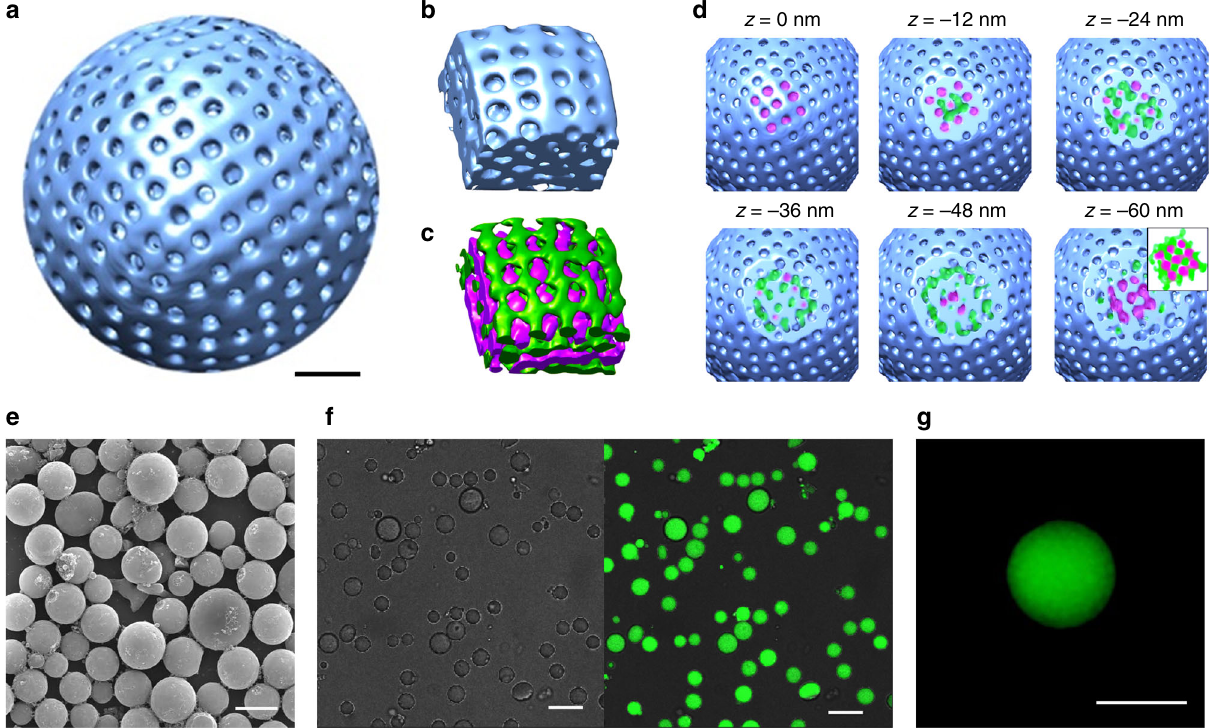
Fig. 2 Three-dimensional representation of the interface and internal structures of PCs. a 3-D reconstructed TEM tomograms of the PC of PEG550 3 -PS 150 . Scale bar is 100 nm. b The 3-D tomogram of the part of the PC of PEG550 3 -PS 150 showing the circumferential bilayer and internal cubic membrane. c The internal non-intersecting water channel networks embedded within the PC. d Cross-sectional images of the 3-D tomogram along z direction. The inset shows merged images of double networks. The magenta channel is open at the interface, and the green remains closed. e SEM image of the PCs of PEG550 3 -PS 150 encapsulating fl uorescein within the closed channel networks. Scale bar is 10 μ m. f Optical and confocal laser scanning microscopy of